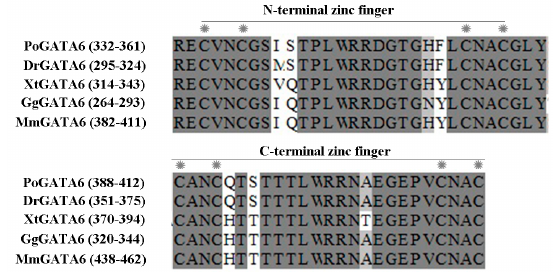
Figure 2. Amino acid sequence alignment of zinc finger domains of PoGATA6, DrGATA6, XtGATA6, GgGATA6 and MmGATA6. Asterisks show the cysteine that generates each zinc finger domain. Abbreviations: Po, P. olivaceus ; Dr, D. rerio ; Xt, X. tropicalis ; Gg, G. gallus ; Mm, M. musculus .